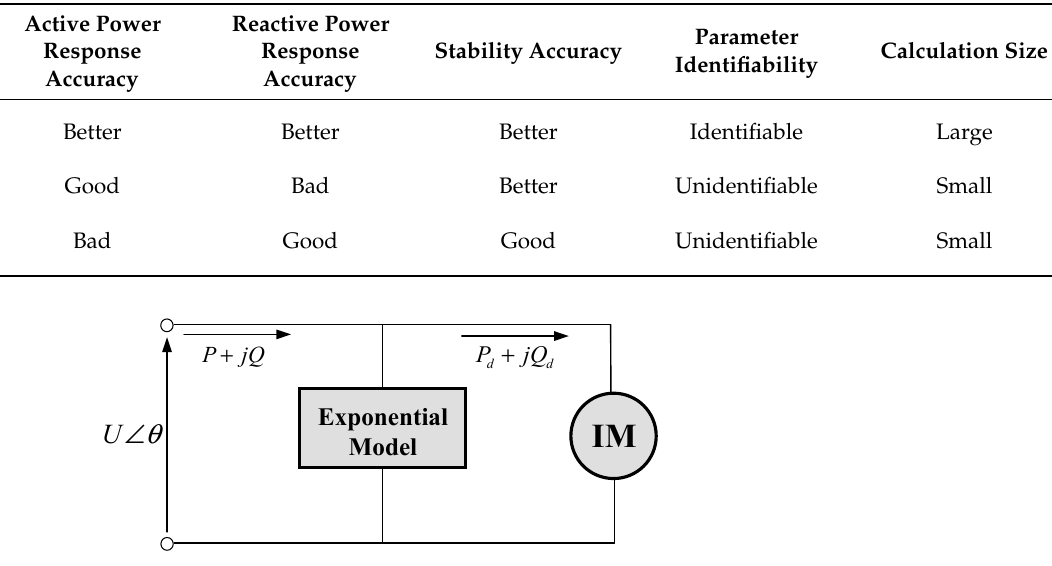
Figure 2. A schematic of the exponential-induction motor model.